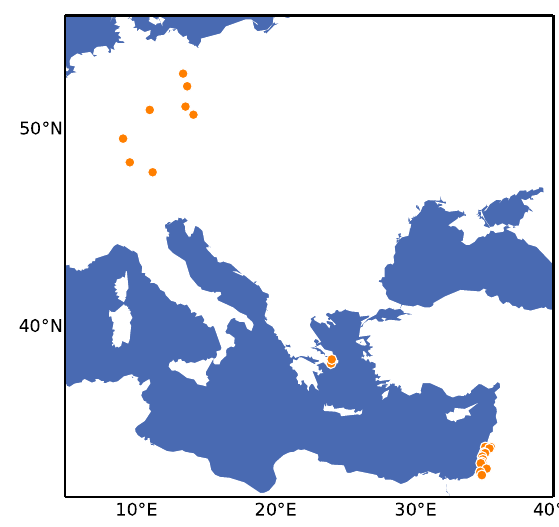
Figure 5. A map of the sites where flowers of P. rhoeas were collected for our study. Sites include ten locations in the East Mediterranean (Israel), two locations in the North Mediterranean (Greece), and eight locations in Central Europe (Germany).